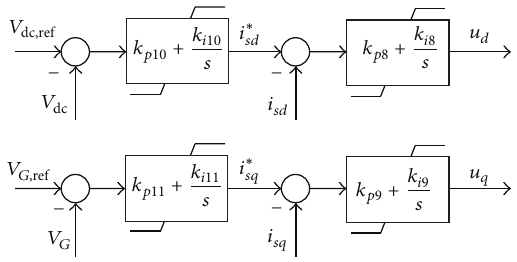
Figure 6: The control system of the grid side